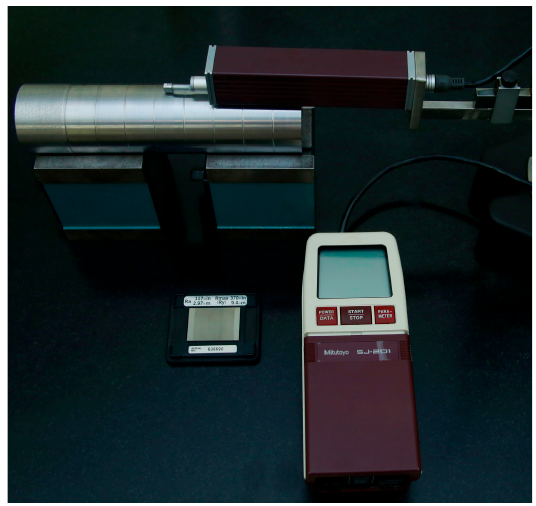
Figure 2. Setup for surface roughness measurement. Figure 2. S etup for surface roughness measurement. Figure 2. S etup for surface roughness measurement.